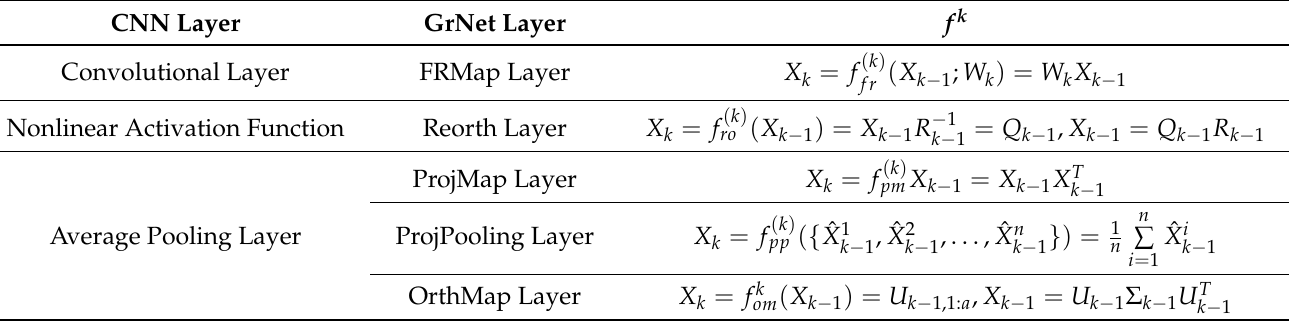
Figure 2. Illustration of GrNet structure. ( I ): Projection Block. ( II ): Pooling Block. ( III ): Output Block. Table 1. Mapping function of each layer in GrNet and the corresponding layer in